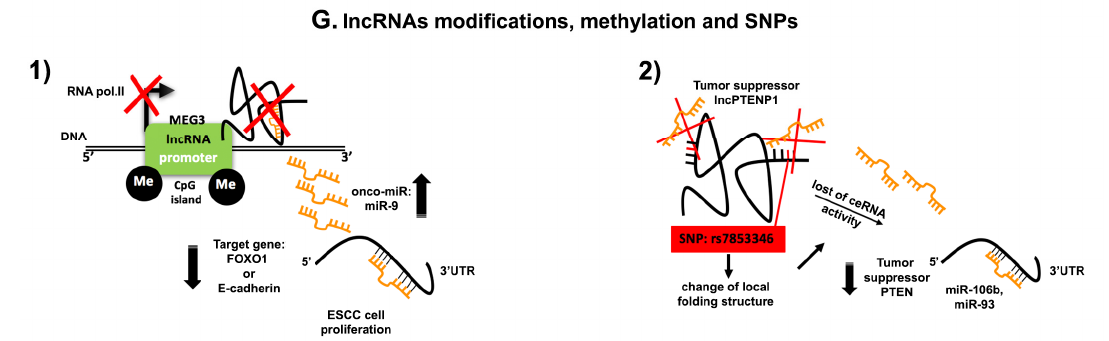
Figure 3. Disruption of ncRNA Networks in Cancer. ( A ): miRNA editing: in glioblastoma, ADAR2 edit the precursors of miR-222/221 and miR-21 and decrease expression of the corresponding oncomiRs in vitro and in vivo, ( B) : Epigenetic regulation: Methylation and deacetylation of miR-127 promoter suppresses expression of the tumor suppressor miRNA. Consequently, BCL6 oncogene expression increases. ( C ): Uridylation of miRNA and lncRNA: the enzyme TUTase adds Uridine groups at the 3 (cid:48) -end of pre- let-7 and the lncRNA Rmrp. Degradation of oligo-Uridine tails through the exonuclease Dis3L2 unified in the DMD pathway may explain the reduced expression of let-7 and other tumor suppressor miRNAs as well as lncRNAs deregulation in cancer. ( D ): 3 (cid:48) UTR regulatory sequences, ARES: ARES interact with micro-ribonucleoproteins (microRNPs) such as AGO2 as a complex with other proteins to regulate the stability and translation of mRNAs in response to external or internal stimuli. miR-369-3 binds ARES, AGO2 and fragile X mental retardation-related protein 1 (FXR1) complex to induce translation of TNF α , in serum starved HEK293 and HeLa cell lines. When cells start to proliferate, miR-369-3 inhibits TNF α . ( E ): RBPs of 3 (cid:48) UTR, Pumilio: Bladder carcinomas selectively down-regulate miRNAs that cooperate with Pumilio to target E2F3, and multiple tumor cell lines shorten the 3 (cid:48) -end of the E2F3 mRNA, removing the Pumilio regulatory elements. ( F ): 3 (cid:48) UTR alterations SNPs: A somatic SNP in the 3 (cid:48) UTR of the oncogene MDM4 created a new binding site for miR-191. This miRNA suppressed only the oncogene MDM4-C allelic variant expression and retarded ovarian cancer progression and the tumor became chemosensitive. ( G ): LncRNA modifications: ( 1 ) Methylation: tumor suppressor, lncRNA MEG3, has binding sites for onco-miR-9, so that it does not bind its targets, FOXO1 and E-cadherin, in ESCC human cell lines. Promoter of lncRNA MEG3 is usually methylated in ESCC and cannot sequester miR-9 and this induces to proliferation of cancer cells. ( 2 ) SNPs: lncRNA PTENP1 polymorphism rs7853346 in GC, change the local folding structure of lncRNAPTENP1. The latter is not able to exert its decoying effect on miR-106b and miR-93, with a consequent reduction of the tumor suppressor PTEN gene